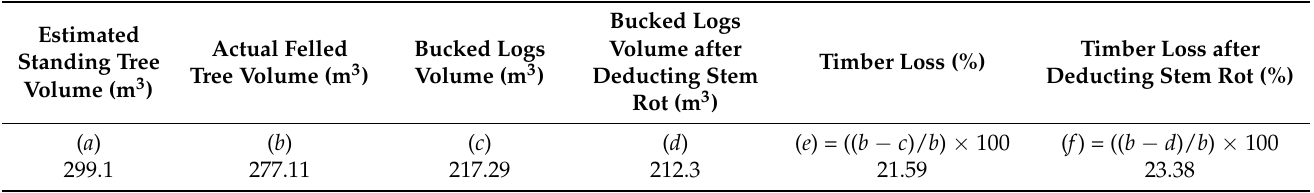
Table 3. Table showing total volumes of standing trees, felled trees, bucked logs, and timber